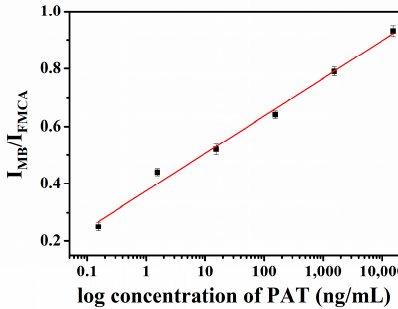
Figure 6. Linear relationship between I MB /I FMCA and the logarithm of PAT concentration in real